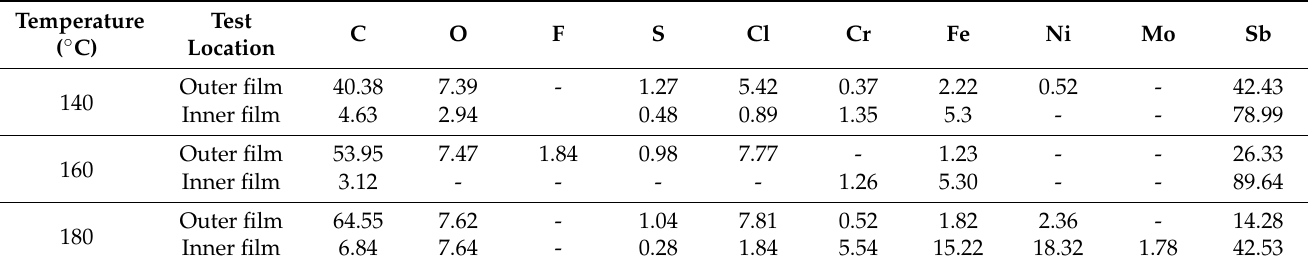
Table 6. Main element contents EDS analysis result of outer and inner films at different test tempera- tures (wt.%).